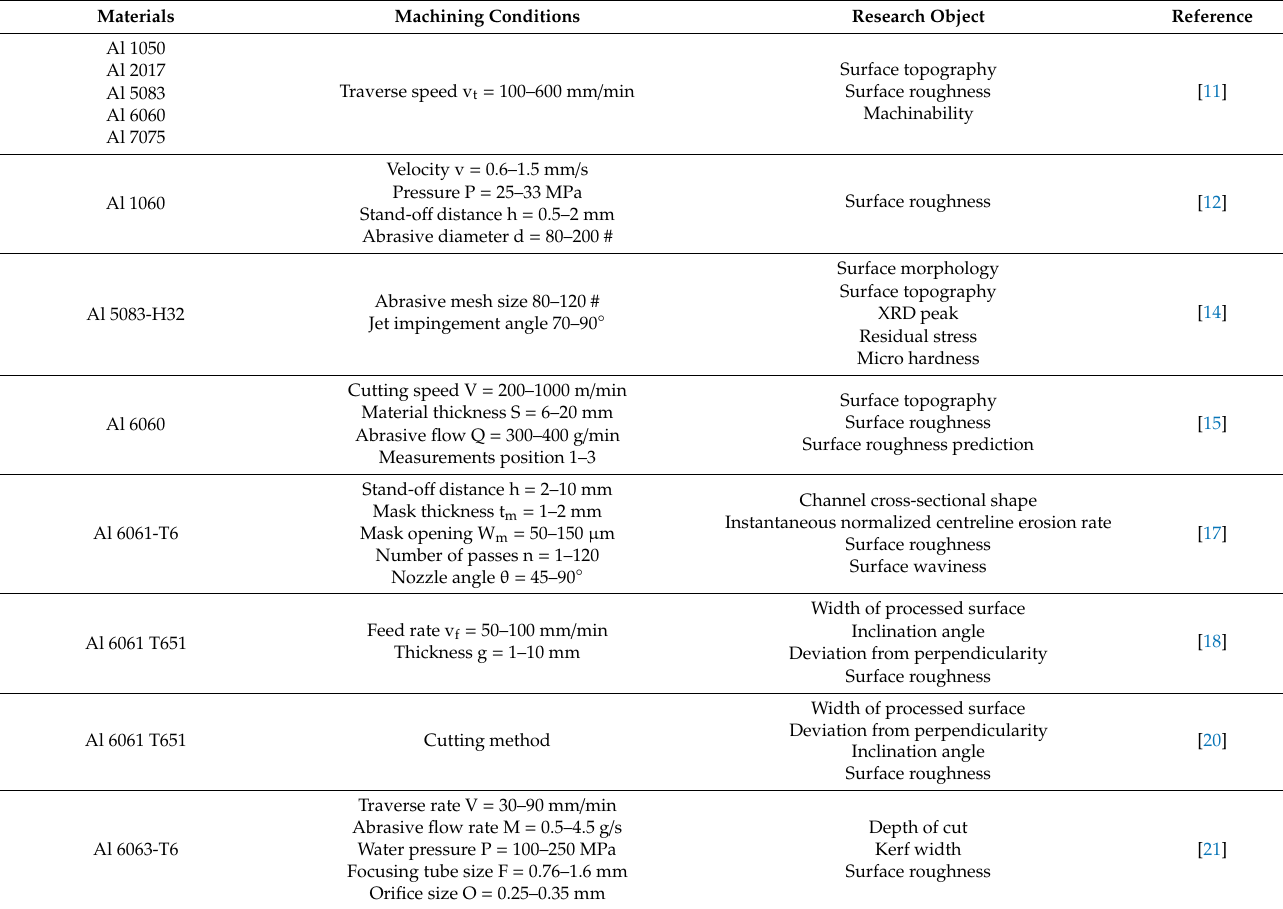
Table 1. Summary of abrasive waterjet cutting light